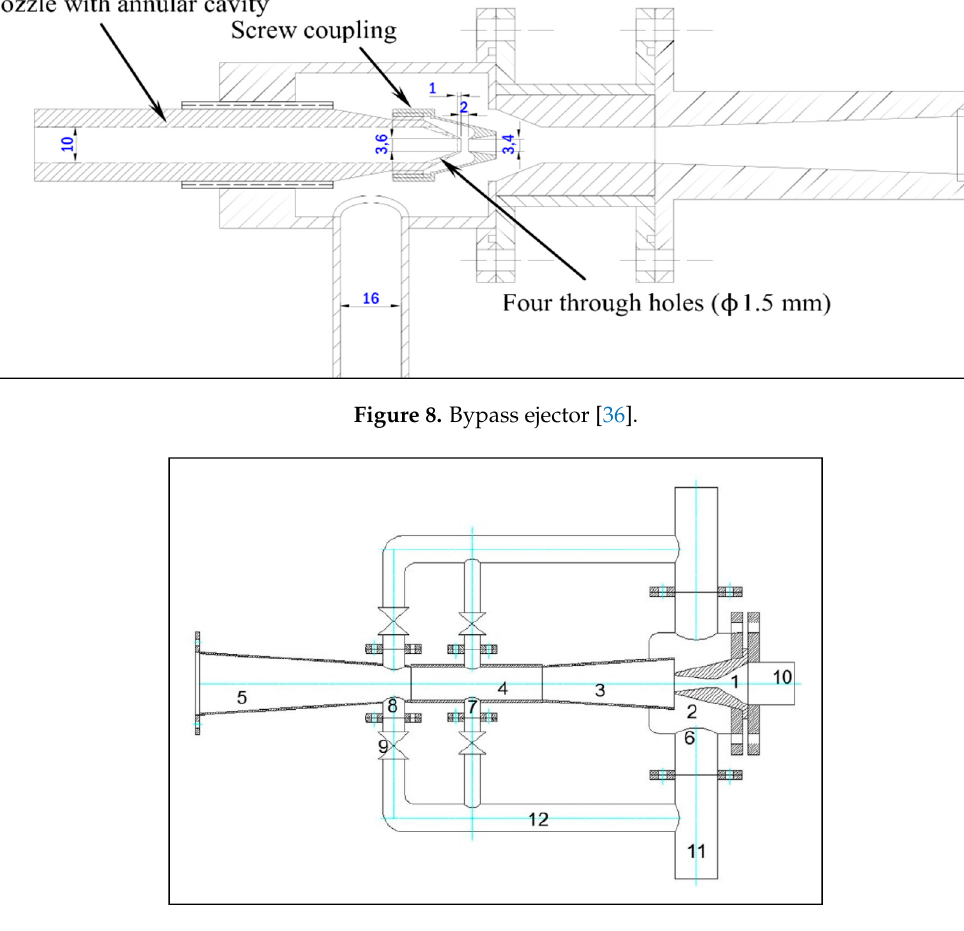
Figure 9. Typical ejector configuration with auxiliary suction [37].